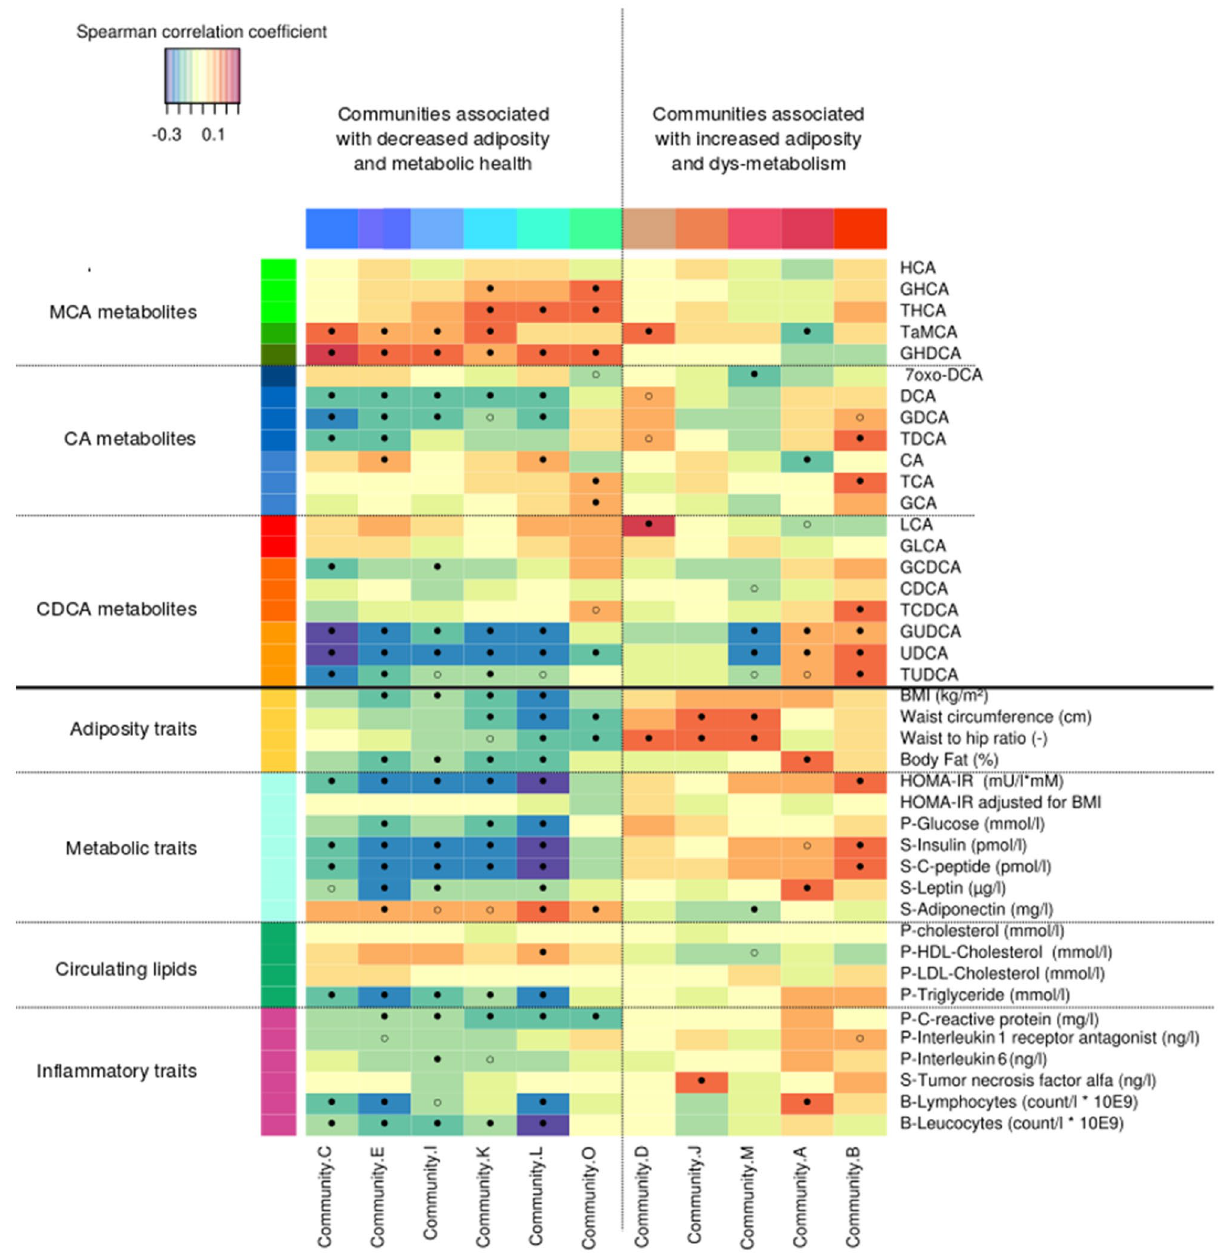
Figure 5. Interplay of the intestinal microbiota, fasting serum levels of bile acids and markers of metabolic health in 283 individuals. Heatmap depicting Spearman’s correlations between microbial communities’ abundances and serum bile acids (top) or bio-clinical traits (bottom), respectively. The level of significance is indicated by the point inside squares: empty circles indicate P < 0.05; filled circles indicate q < 0.05. Only gut microbial communities with at least one significant correlation ( P < 0.05) are shown. Prefix P- and S- indicate plasma and serum, respectively. See ( a ) for the correspondence between the abbreviated bile acid